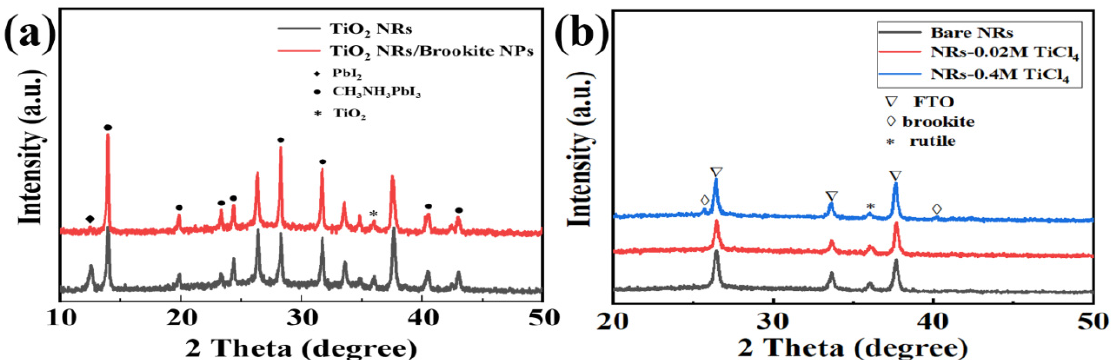
Figure 1. X-ray diffraction (XRD) patterns of ( a ) perovskite based on TiO 2 NR film and TiO 2 NR/brookite NP film; ( b ) bare NRs, NRs treated with 0.02 M TiCl 4 and NRs treated with 0.4 M TiCl 4 .